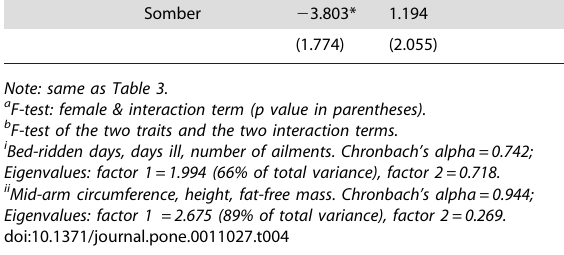
Note: same as Table 3. a F-test: female & interaction term (p value in parentheses). b F-test of the two traits and the two interaction terms. i Bed-ridden days, days ill, number of ailments. Chronbach’s alpha=0.742; Eigenvalues: factor 1=1.994 (66% of total variance), factor 2=0.718. ii Mid-arm circumference, height, fat-free mass. Chronbach’s alpha=0.944; Eigenvalues: factor 1 =2.675 (89% of total variance), factor 2=0.269.